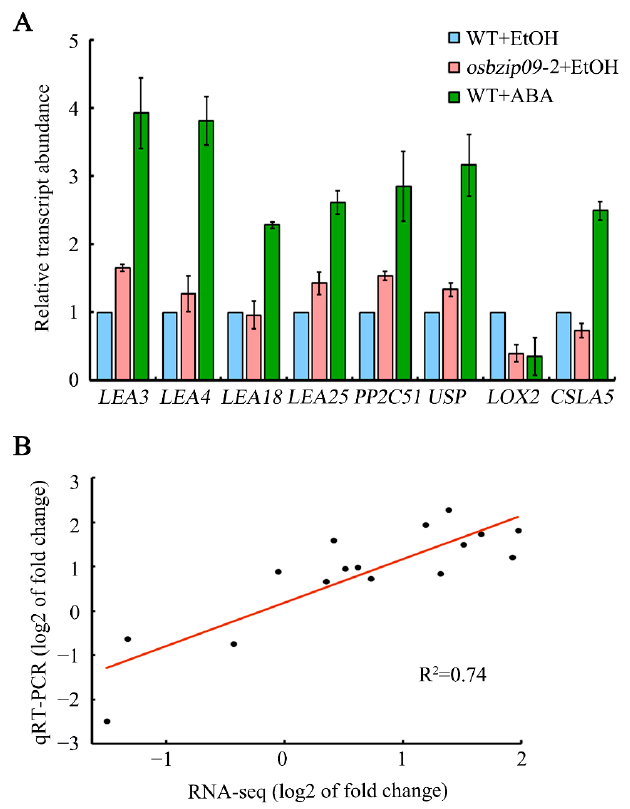
Figure 6. Validation of RNA-seq data for the representative common targets by qRT-PCR. ( A ) qRT-PCR for selected eight representative common targets. ( B ) Correlation of gene expression between qRT-PCR and RNA-seq data. Fold-change values were log 2 transformed.